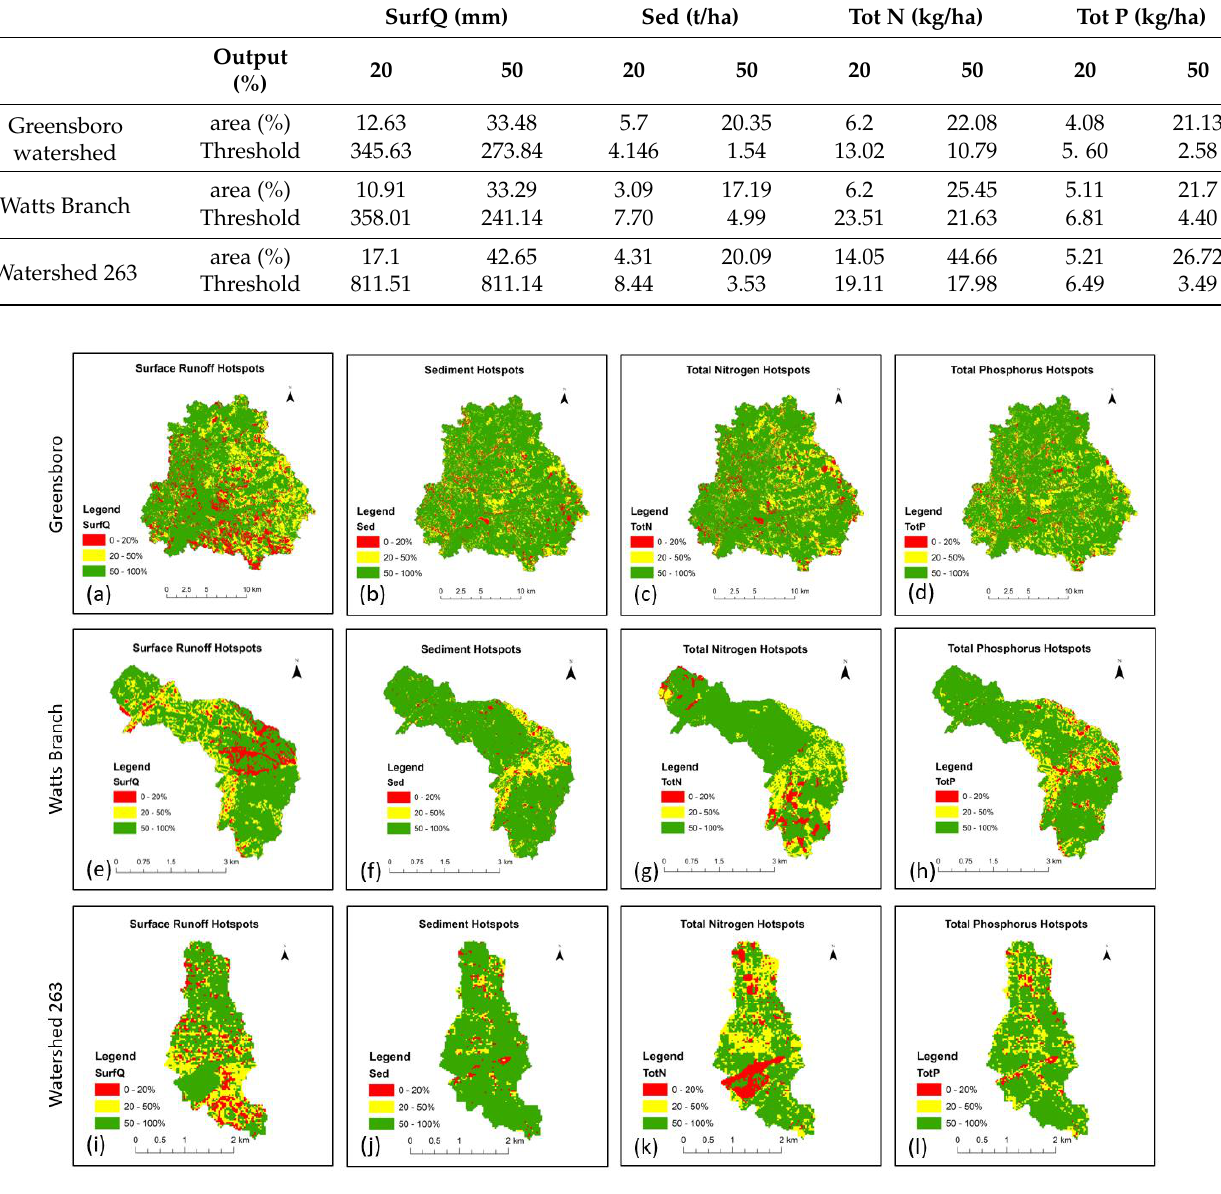
Figure 7. Hotspots of ( a , e , i ) total surface runoff (SurfQ), ( b , f , j ) total sediment (Sed), ( c , g , k ) total nitrogen (Tot N), and ( d , h , l ) total phosphorus (Tot P) in three real watersheds (first row: Greensboro, second row: Watts Branch, third row: Watershed 263). Red and yellow areas in each map account for 20% and 30% of the total output of each constituent, respectively.